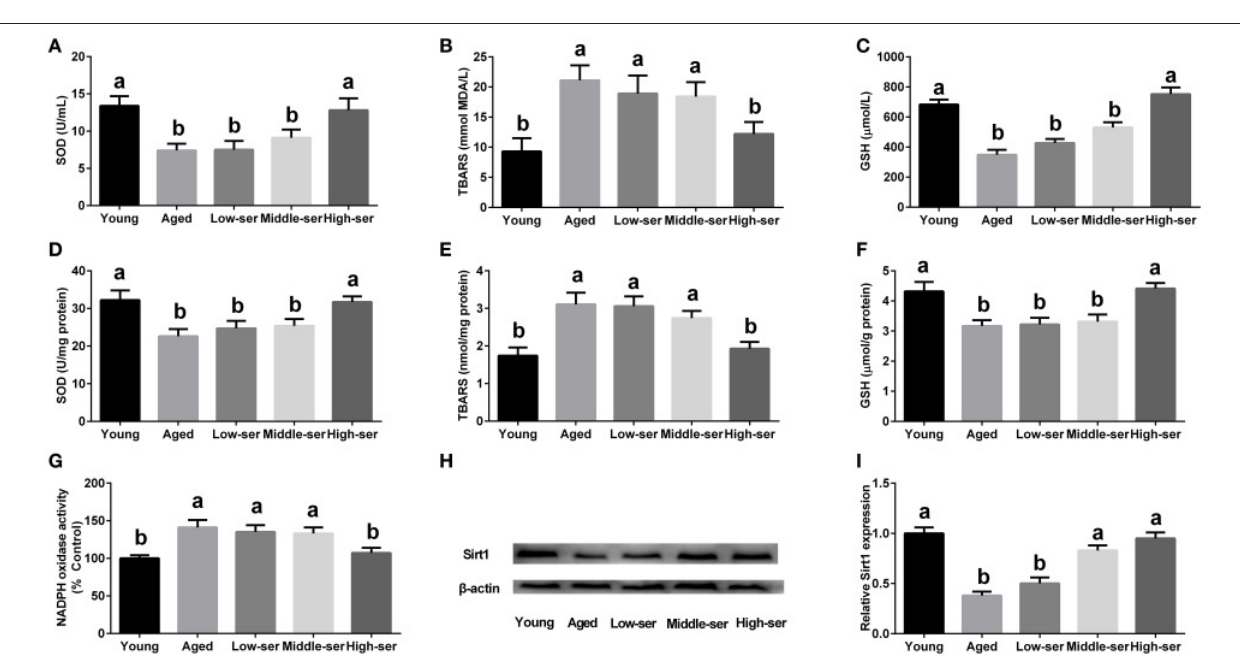
FIGURE 2 | Effects of long-term L -serine administration on oxidative stress in aging mice. (A–C) SOD, MDA, and GSH contents in serum; (D–F) SOD, MDA, and GSH contents in the hypothalamus; (G) NADPH oxidase activity; (H , I) Protein expression of Sirt1. Aged, untreated control mice; Low-ser, mice supplemented with 0.1% (wt/vol) L -serine dissolved in the drinking water; Middle-ser, mice supplemented with 0.2% (wt/vol) L -serine dissolved in the drinking water; High-ser, mice supplemented with 0.5% (wt/vol) L -serine dissolved in the drinking water. Young, adult male mice at the age of 18 months. SOD, superoxide dismutase; MDA, malondialdehyde; GSH, glutathione; NADPH, nicotinamide adenine dinucleotide phosphate. Values are expressed as mean ± SEM, n = 3 for the statistical analysis of western blotting data and n = 8 for the statistical analysis of other data; a,b Means of the bars with different letters were significantly different among groups ( P <